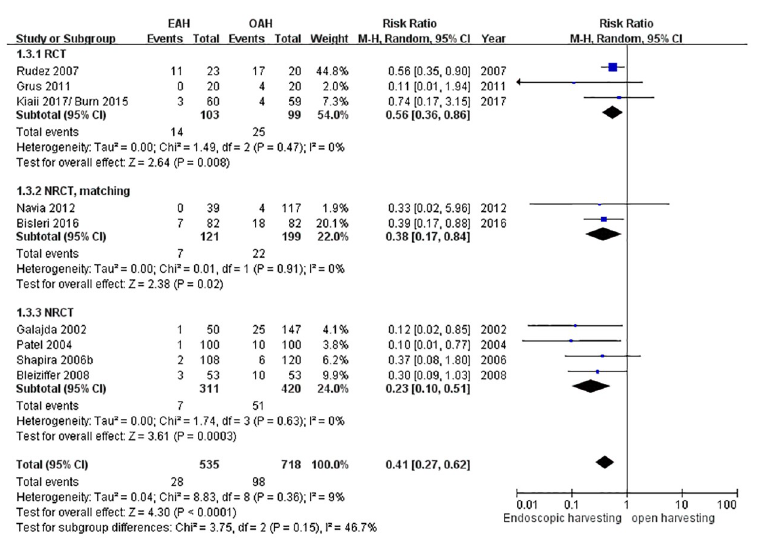
Fig 5. Forest plot for neurological complications.